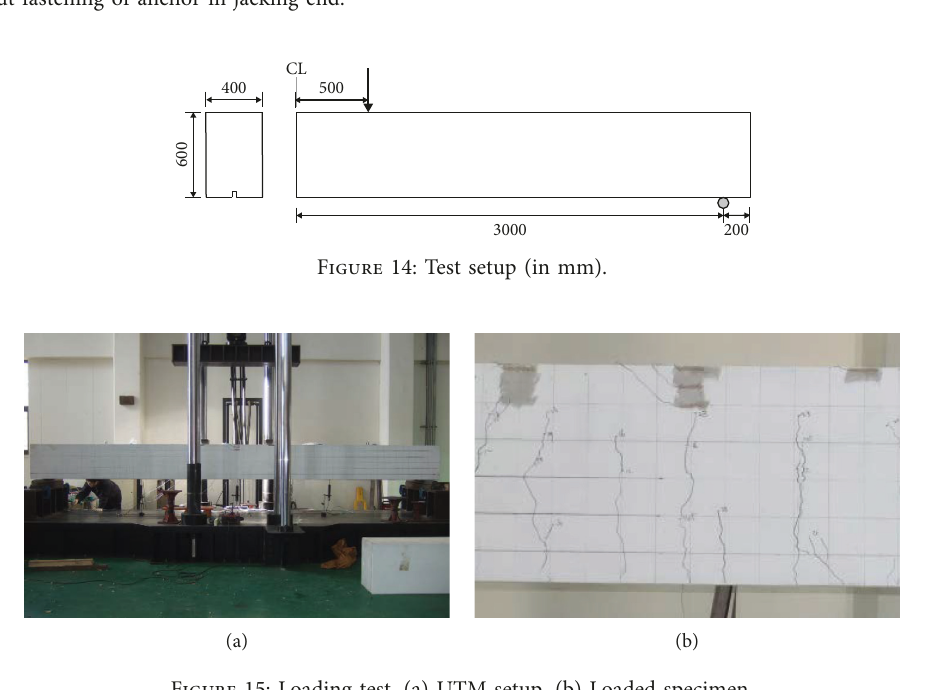
Figure 13: Installation process of anchor and FRP tendon. (a) Grooving. (b) Drilling of anchor bolt holes. (c) Leveling of groove by epoxy. (d) Fastening of anchor bolt. (e) Installation of anchor bolt using torque wrench. (f) Installed anchor. (g) Fixation of anchor at the fixed end by washer. (h) Nut fastening of anchor in jacking end.